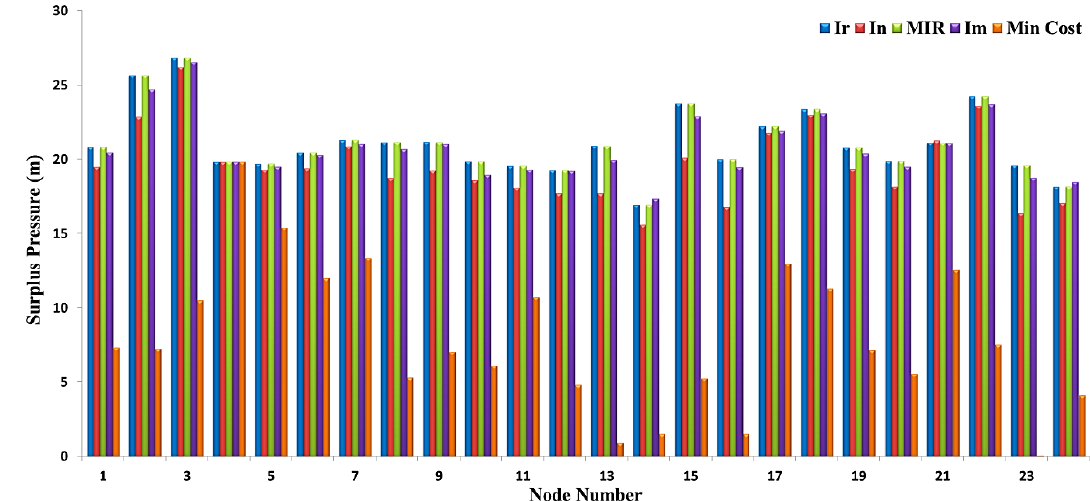
Figure 6. Surplus pressure of the real-life WDN for solutions of maximum reliability criteria and minimum cost.